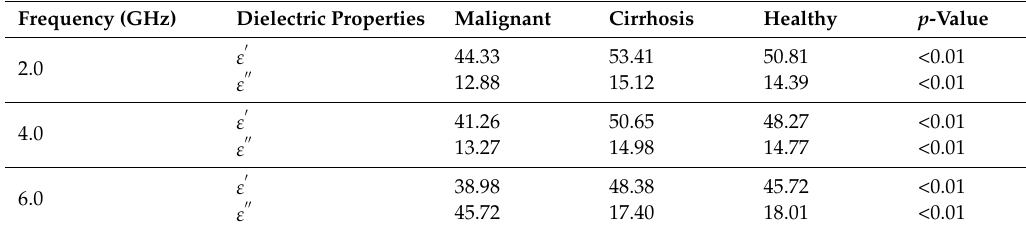
Figure 4. Comparison of mean, median, and standard deviation of malignant, cirrhosis, and healthy rat liver tissues at 1 GHz: ( a ) for relative permittivity; ( b ) for dielectric loss. Table 3. Mean dielectric properties and p -values of selected measurements at three different